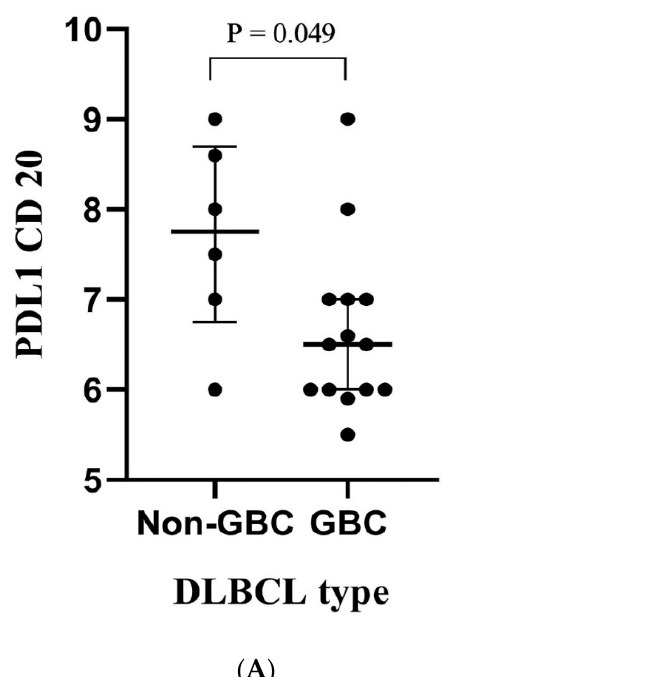
( J ) Figure 3. Percentage of PD-L1+CD20+ and PD-1+CD20+ in pre-therapy DLBCL patients with B symptoms ( A , B ); bone marrow involvement ( C , D ); DLBCL type ( E , F ); Ann Arbor stage ( G , H ) and ECOG performance ( I , J ). Each dot represented one patient. In total, 20 DLBCL patients were in- volved. NS: not significant; GCB: germinal center B-cell; ECOG: Eastern Cooperative Oncology Group; -ve: negative; +ve: positive. p -value is shown. * p < 0.05. Additionally, the clinical relevance of these genes in post-therapy DLBCL patients